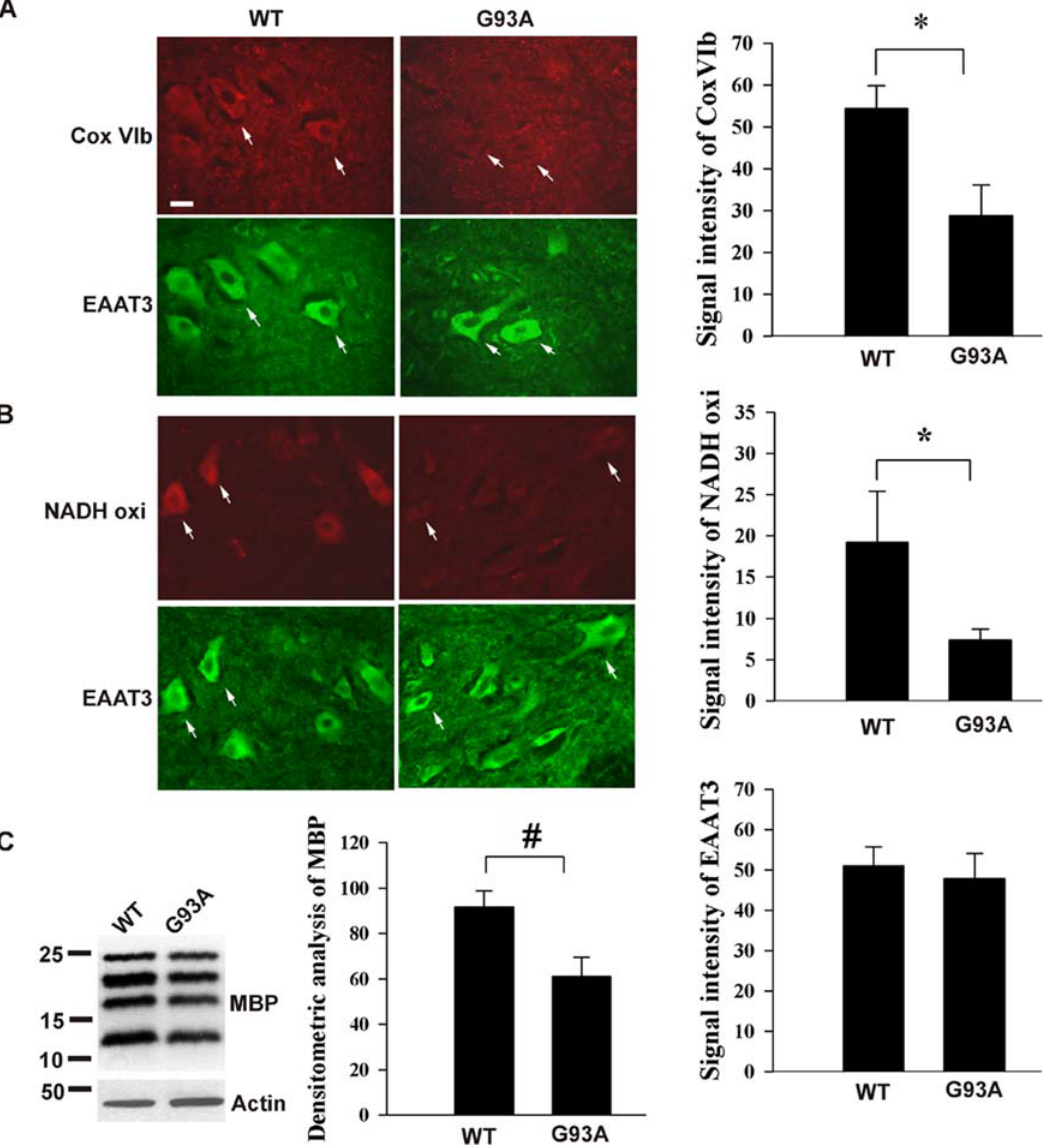
Figure 5. Some proteins corresponding to oxidized mRNA species are decreased. ( A & B ) immunofluorescent staining of lumbar spinal cord sections prepared from indicated mice (n=3) showed that downregulation of protein levels in SOD1 G93A mice was found in cytochrome c oxidase VIb ( Cox VIb ) and NADH-ubiquinol oxidoreductase subunit 39 kDa ( NADH oxi ), whose mRNAs were highly oxidized but not EAAT3 protein, whose mRNA was not oxidized. Statistic analysis of immunoreactivity within motor neurons (n=20) is shown. * P , 0.0001 ( C ) Immunoblot analysis showed that MBP, whose mRNA was oxidized, was decreased. Densitometry analysis (standardized by actin intensity) of immunoblot is shown (n=3). # P ,